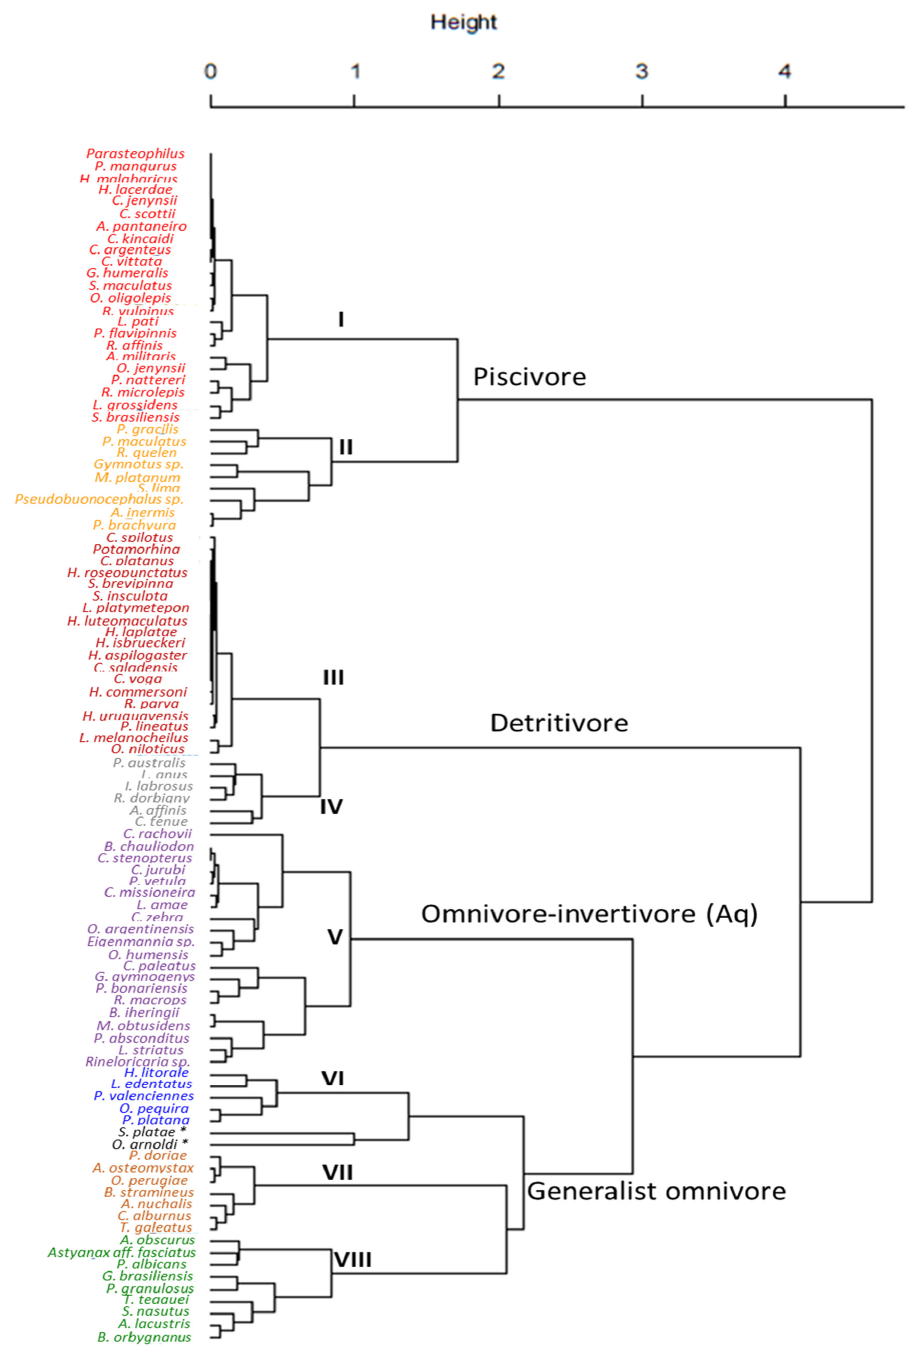
Figure 2. Cluster analysis showing trophic classification of 100 fish species along the Uruguay River. The text in the main tree branches corresponds to the broad scale trophic classification into four large trophic groups. Within each group, a statistically significant separation into more detailed sub-groups is made and marked with numbers and di ff erent text font colours. The final eight trophic groups are: I: Piscivore; II: Piscivore-invertivore; III: Detritivore; IV: Omnivore-detritivore; V: Omnivore-invertivore—(Aq.); VI: Omnivore-planktivore; VII: Omnivore-invertivore—(Terr.); and VIII: Omnivore-herbivore—(Terr.). The two species with * were excluded from groups due to their unique diet composition. Species abbreviations are shown, for full species names and detailed dietary characterization see Table